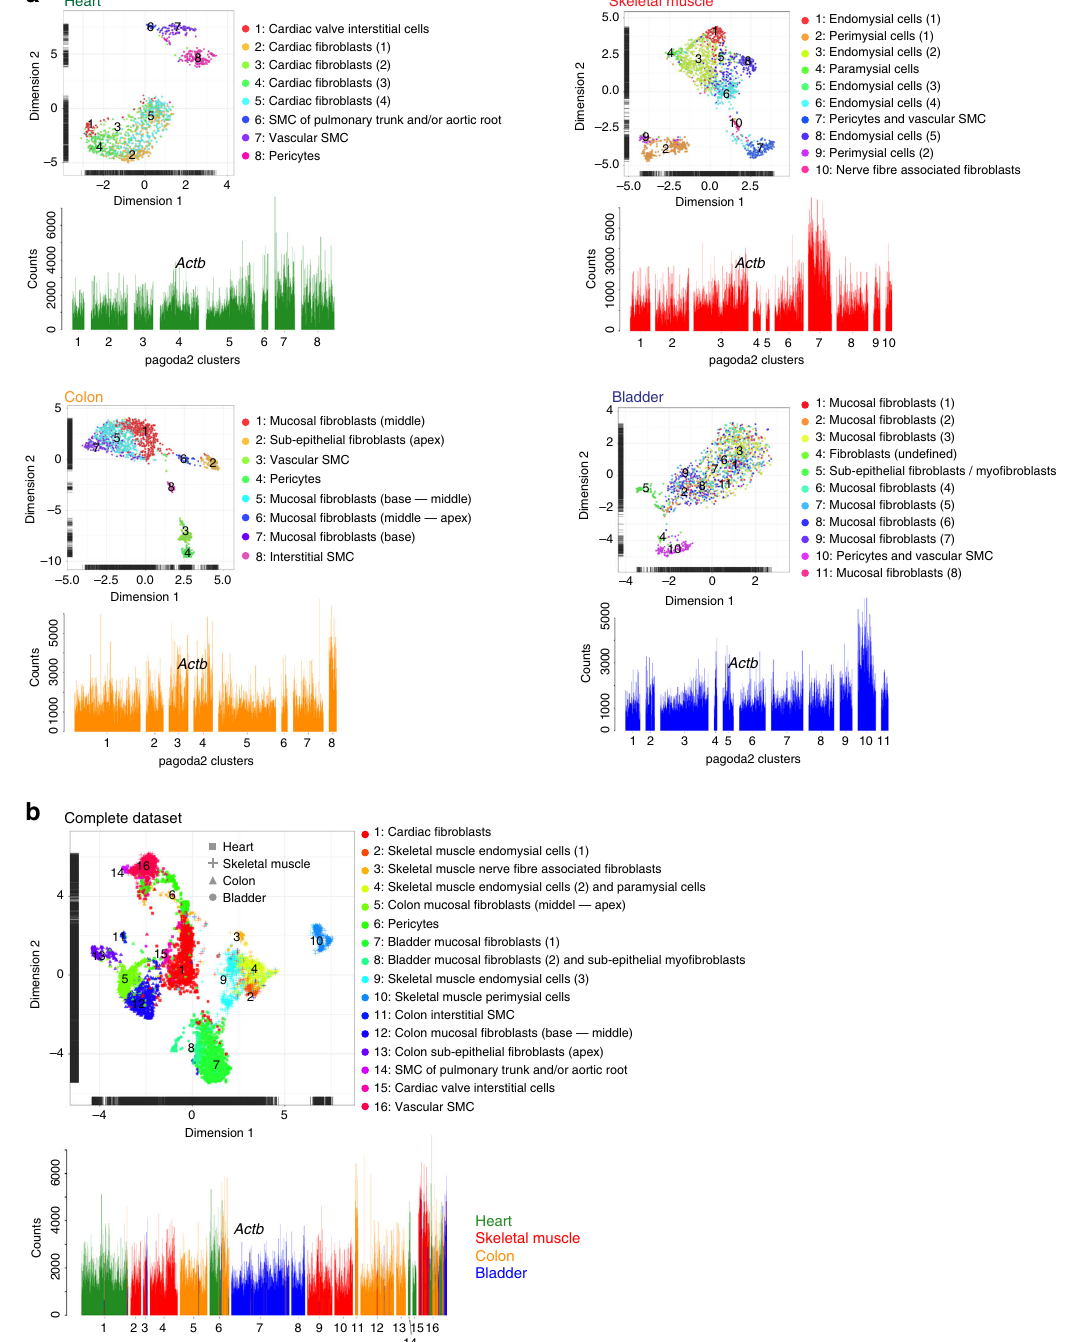
Fig. 9 Cell annotation summary. a UMAP visualization with pagoda2 cluster annotation and bar plots showing Actb expression of organ speci fi c datasets. b UMAP visualization with pagoda2 cluster annotation and bar plot showing Actb expression with organ of origin color coded in the complete